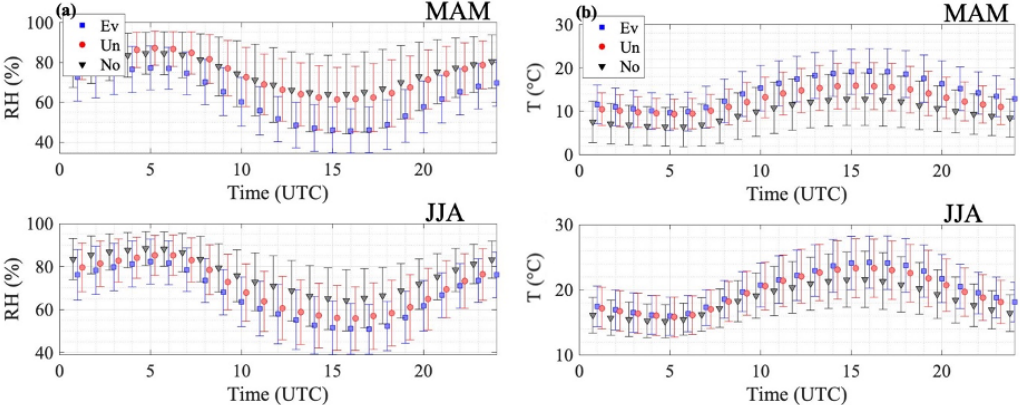
Figure 7. Diel variations (UTC) of the mean relative humidity (RH, a ) and mean temperature (b) observed during the NPF event days (Ev, blue squares), undefined days (Un, red dots), and non-event days (No, black triangles) during spring (MAM) and summer (JJA) seasons. The error bars correspond to one standard